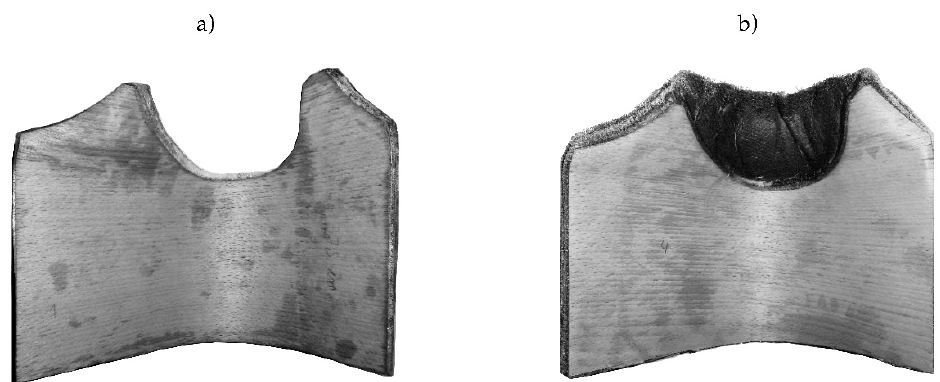
Figure 3. Cut-out of specimens ( a ) reference, ( b ) with flax fiber reinforcement.